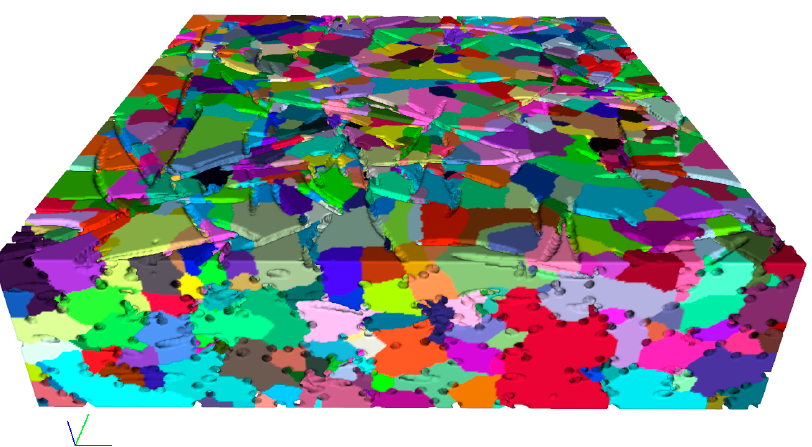
Figure 7. The boundary faces are divided into many boundary cells as the byproducts of watershed segmentation in the 3D domain.